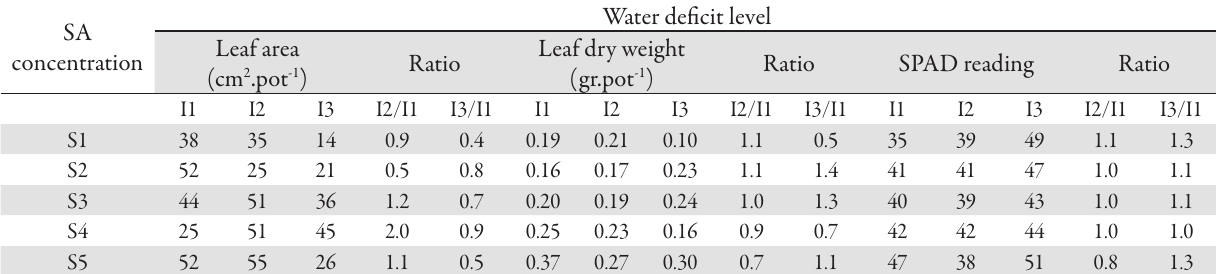
Tab. 3. Interactive effects of different water deficit levels and various SA concentrations on leaf area, leaf and root dry weight